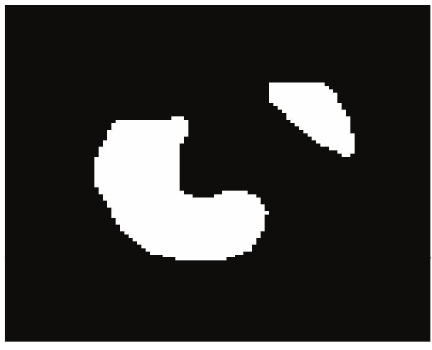
Figure 1: Synthetic image. Figure 2: Expected foreground.